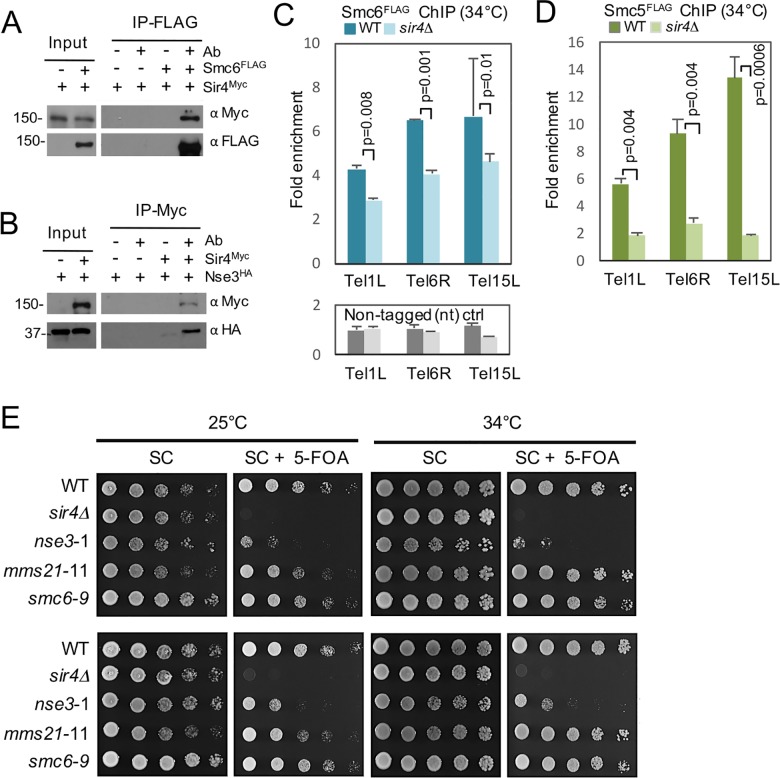
Smc5/6 physically associate with Sir4 and is important for TPE.(A) Co-immunoprecipitation (Co-IP) as described in the materials and methods section was performed in cells carrying Sir4Myc and Nse3HA (JC3736) with Nse3HA (JC2823) as control or (B) Sir4Myc and Smc6FLAG (JC3853) with Smc6FLAG (JC1594) as a control. (C) ChIP was performed on Smc5FLAG in wild type (JC3728) and sir4Δ (JC3720) and (D) Smc6FLAG in wild type (JC1594) and sir4Δ (JC3732) and non-tagged (nt) strains in wild type (JC470) and sir4 Δ (JC3737) as described in Fig 1E. The fold enrichment levels are relative to the late-replicating control region on Chr V for n≥3 experiments with the mean ± SD at three native subtelomeres (Tel1L, Tel6R and Tel15L) with p values < .05 from a two-tailed t-test indicated. (E) TPE was determined in strains with the URA3 reporter at the adh4 locus of Chromosome VIIL. Tenfold (1:10) serial dilutions of overnight cultures were spotted onto SC (complete medium) and SC + .1% 5-FOA plates at 25°C and 34°C in wild type (JC1991), sir4Δ (JC3818), nse3-1 (JC3860), mms21-11 (JC1080) and smc6-9 (JC1077) isogenic strains.